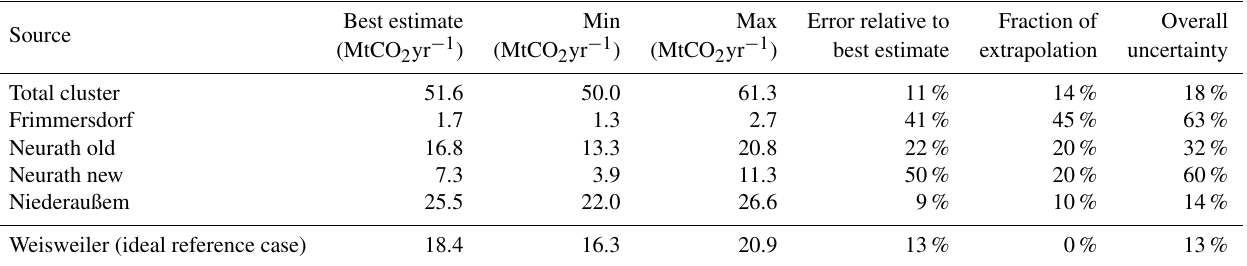
Table 3. Summary of all standard methods applied to the different plumes measured in situ (for more details see the extended table in the Supplement). For the discussion see text in Sect. 3.1. The best estimate is the average of the sensitivity analyses. The minima and maxima were calculated combining the minima and maxima of either the primary measurements (e.g. for the total cluster, Frimmersdorf, and Niederaußem), or by using the worst-case combinations for sums and differences. The split into Neurath old and new was done as shown in Fig. 8.